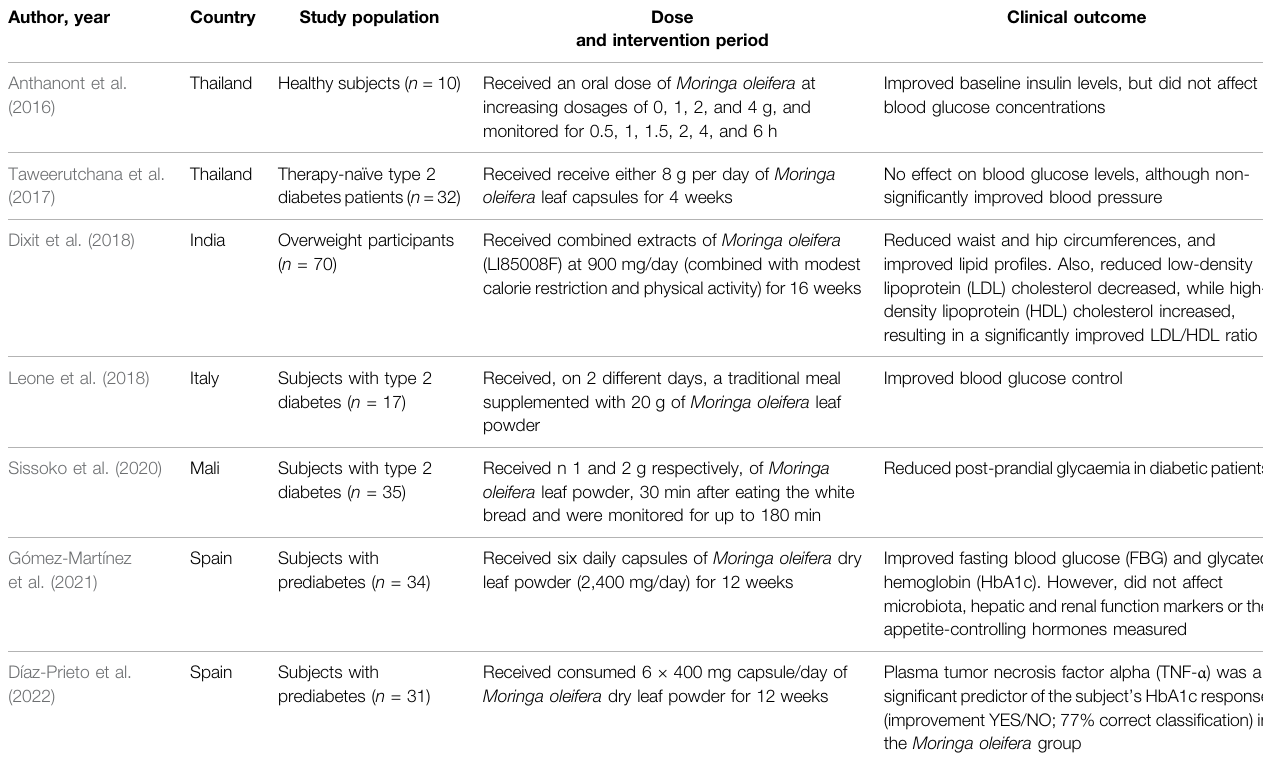
TABLE 3 | An overview of clinical studies reporting on the antidiabetic properties of Moringa oleifera . Author, year Country Study population Clinical